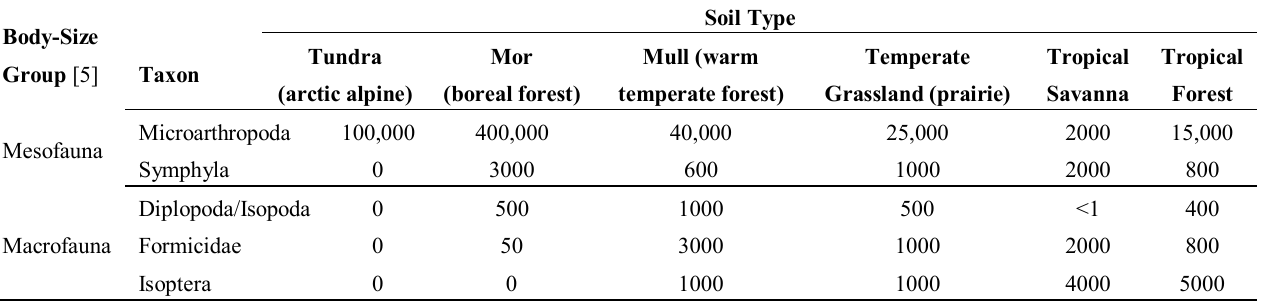
Table 1. Approximate abundance (number m −2 ) of hemi- and euedaphic arthropods in different soils